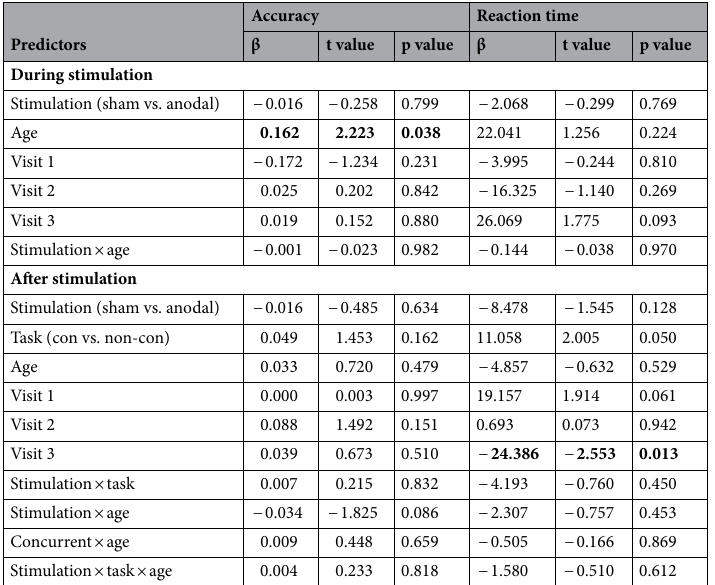
Table 3. Coefficients and corresponding t values and p values for 2-back accuracy (d ′ ) and reaction time during and after stimulation. Significant results are printed in bold.